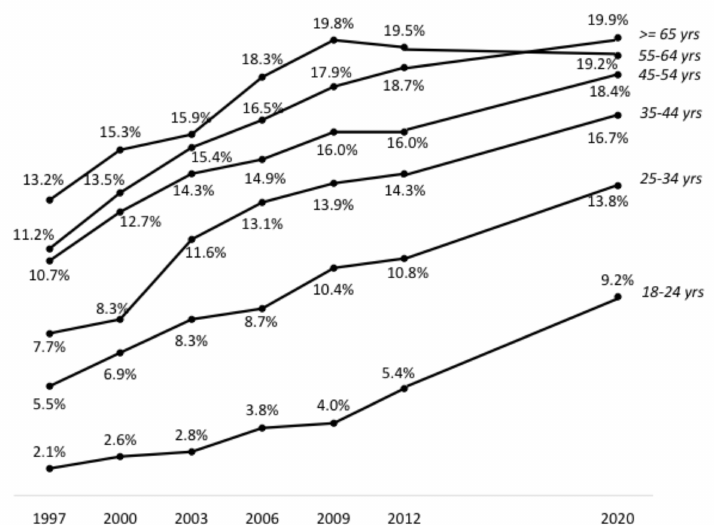
Figure 4. Evolution of the prevalence of obesity (BMI ≥ 30 kg/m 2 ) by age groups, Obepi-Roche 1997–2012 [8] with addition of LCO 2020 Obepi-Roche